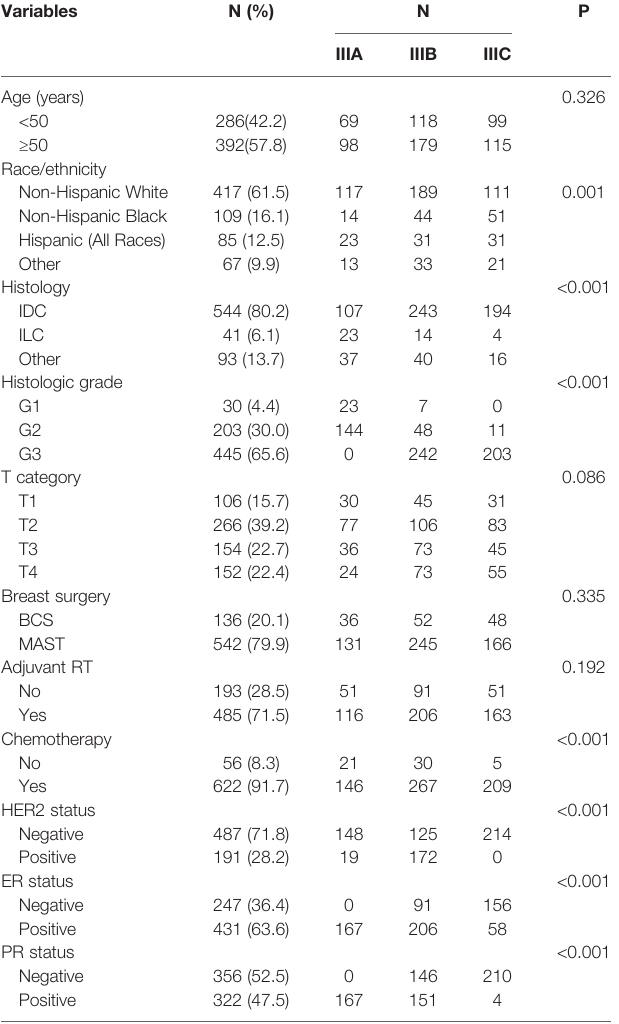
TABLE 1 | Patient characteristics.